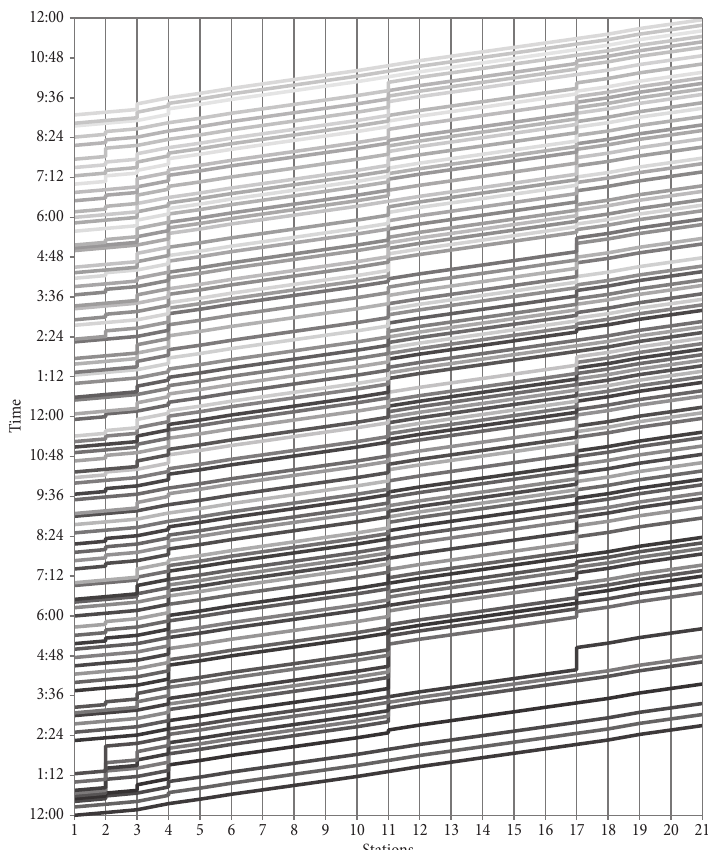
Fig. 6. The impact of different train types on railway line capacity